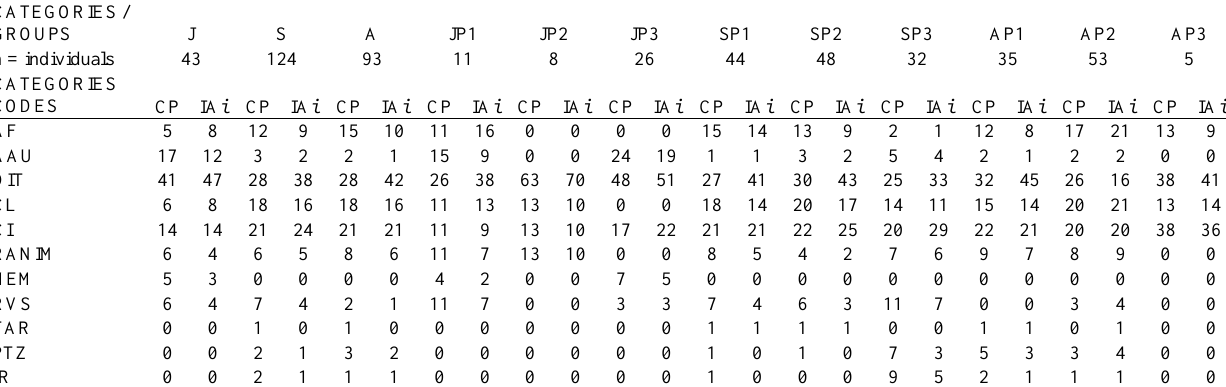
Table 5. Contribution of microscopic diet categories of D. langei represented by Percentage Composition (CP) and Feeding Index (IA ), comparing the total length (Lt) categories Juveniles (J = Lt < 3 cm), Semi-adults (S = 3 < Lt < 8 cm) and Adults (A i = Lt > 8 cm) and three sites sampled along the catchment: site 1 (P1), an upstream first order section of the basin near its spring; site 2 (P2), a second order middle section of the basin; and site 3 (P3), a downstream third order section of the basin. The group codes mean respectively: JP1 = Juveniles Point 1, JP2 = Juveniles Point 2, JP3 = Juveniles Point 3, SP1 = Semi-adults Point 1, Microscopic diet codes are: AF = Microscopic Filamentous Algae, AAU = Microscopic autochthonous Arthropods, DIT = Unicellular Diatoms, CL = Unicellular Chlorophytes, CI = Unicellular Cyanophytes, RANI = Non Identifiable Arthropod Parts, NEM = Nematodes, RVS = Higher Plant Remains, TAR = Tardigrada, PTZ = Protozoa and IR = Remaining